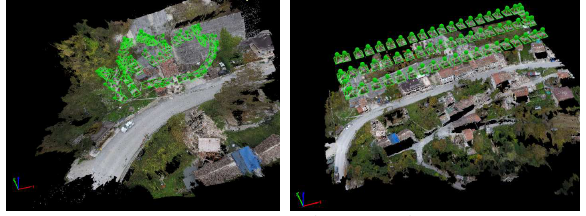
Figure 8. Nadiral and oblique configuration for DJI acquisition